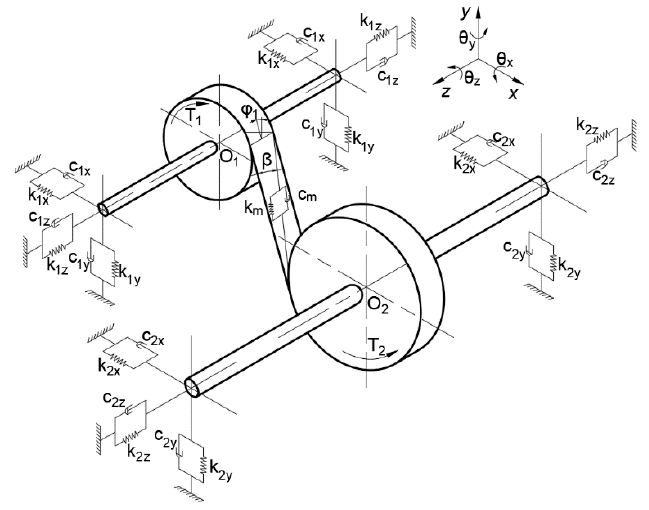
Figure 2. Bend-torque-shaft-swing coupling model for high-speed stage helical gear transmission system.